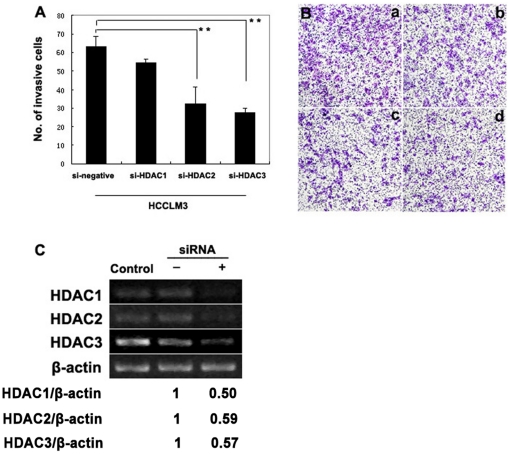
Alteration of class I HDAC isoform levels in HCCLM3 cells changes its invasiveness in vitro.(A) Selective knockdown of HDAC3 and HDAC2 led to reduced invasiveness of HCCLM3 (**P<0.01, Student t test). (B) Representative images of invasiveness of HCCLM3 cells transfected with negative siRNA (a) or siRNA against HDAC1(b), HDAC2(c), and HDAC3 (d). The transwell invasion assay showed that HCCLM3 cells transfected with siRNA against HDAC2,3 displayed a markedly decreased invasiveness behavior, as indicated by a significant decrease in the average number of cells invaded through the matrigel in comparison with the control siRNA. (C) Effective silencing of HDAC1, 2, 3 mRNA in HCCLM3 after siRNA treatment for 48 hours.